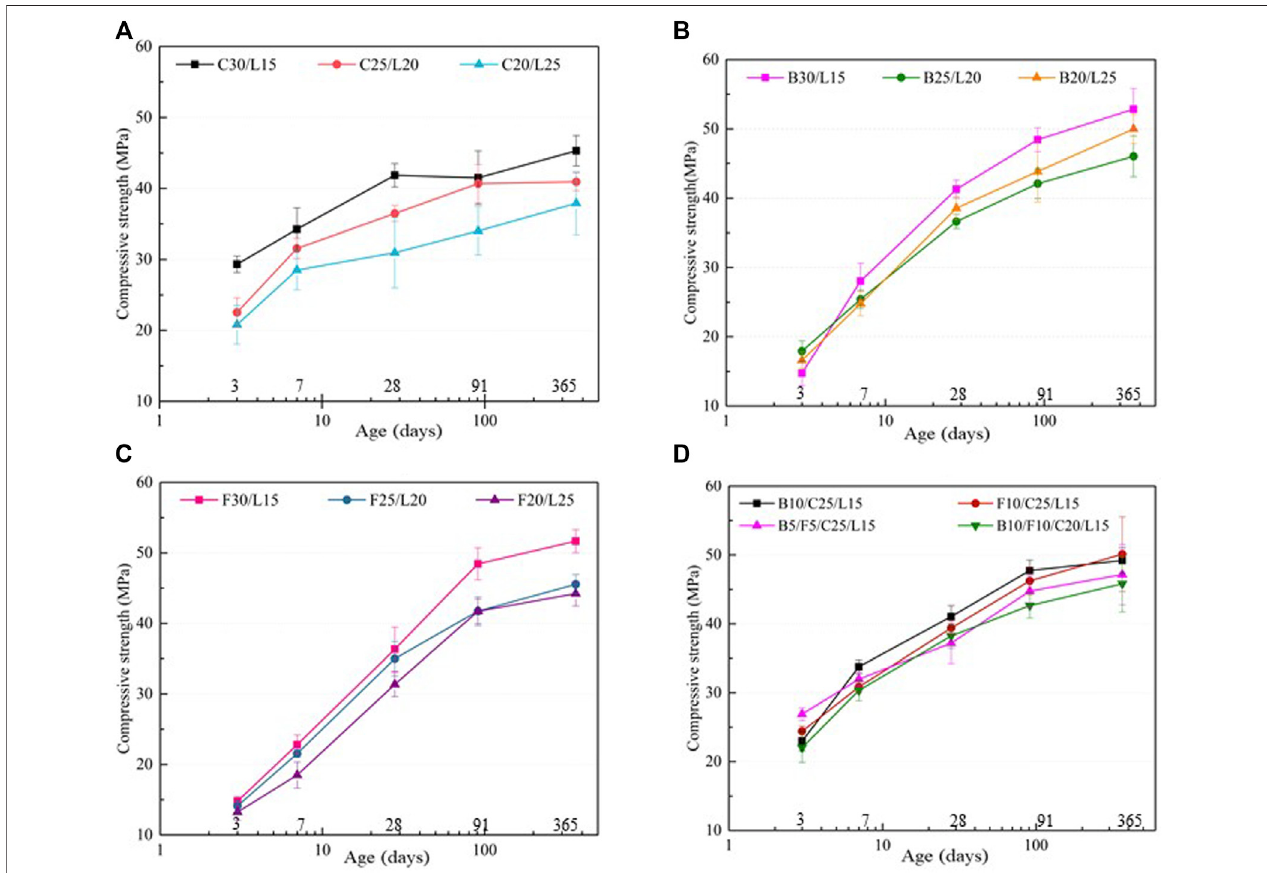
FIGURE3| Compressivestrengthofblendedcementusing (A) calcinedclayandlimestone fi ller, (B) blastfurnaceslagandlimestone fi ller, (C) fl yashandlimestone fi ller and (D) multiple additions at 3, 7, 28, 91 and 365 days.